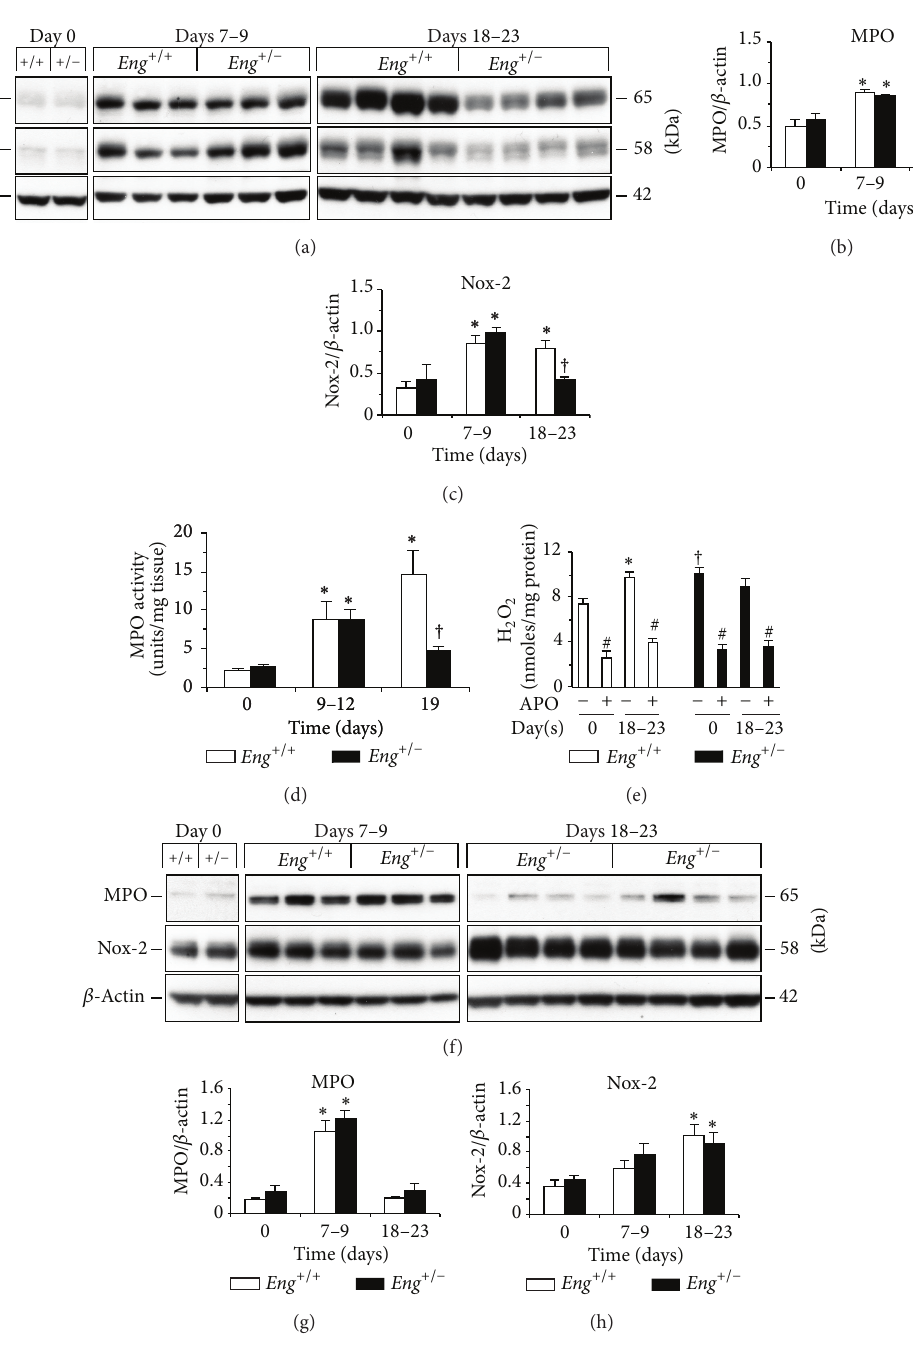
Figure 4: Reduced colonic MPO and Nox-2 expression in colitic Eng +/− mice are not associated with an intrinsic bone marrow defect. (a) Representative Western blots show colonic expression levels of MPO and Nox-2 in basal and colitic mice, normalized to 𝛽 -actin (days 0 and 18–23 images are derived from a single immunoblot). Histograms illustrate densitometric analysis of (b) MPO and (c) Nox-2 expression (for MPO: 𝑁 = 6 –8 mice for day 0 and 4–9 mice for days 7–9 and 18–23; for Nox-2: 𝑁 = 4 -5 mice for day 0, 3–7 for days 7–9 and 18–23). (d) Colonic MPO enzymatic activity was assessed in Eng +/+ and Eng +/− mice at days 0, 9–12, and 19 of colitis ( 𝑁 = 6 –8 mice for days 0, 9–12, and 19). (e) The H 2 O 2 levels in colons of mice at days 0 and 18–23 were measured using an Amplex Red assay. Apocynin (APO) was utilized as an NADPH oxidase inhibitor ( 𝑁 = 6 –8 mice for day 0 and 4–7 for days 18–23). (f) Total bone marrow cells were isolated and MPO and Nox-2 expression was assessed using Western blot analysis. Representative images show bone marrow expression levels of MPO and Nox-2 in basal and colitic Eng +/+ and Eng +/− mice, with 𝛽 -actin as the normalizing factor (days 0 and 18–23 images are derived from a single immunoblot). Histograms illustrate densitometric analysis of (g) MPO and (h) Nox-2 expression at all-time points tested (for MPO and Nox-2: 𝑁 = 3 mice for day 0 and 3–5 mice for days 7–9 and 18–23). ∗ 𝑃 < 0.05 versus corresponding day 0, † 𝑃 < 0.05 versus corresponding Eng +/+ group, and # 𝑃 < 0.05 versus corresponding untreated group. Results represent mean ±